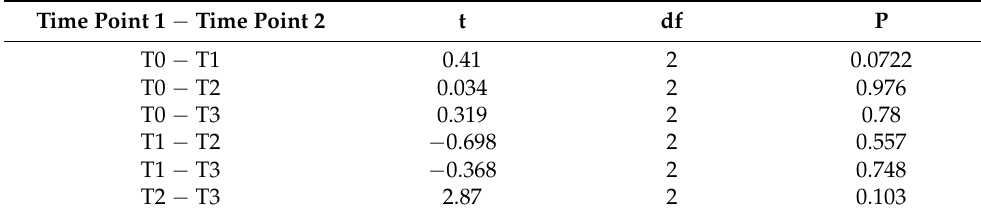
Table 6. Narration task (Frog, Where Are You?).